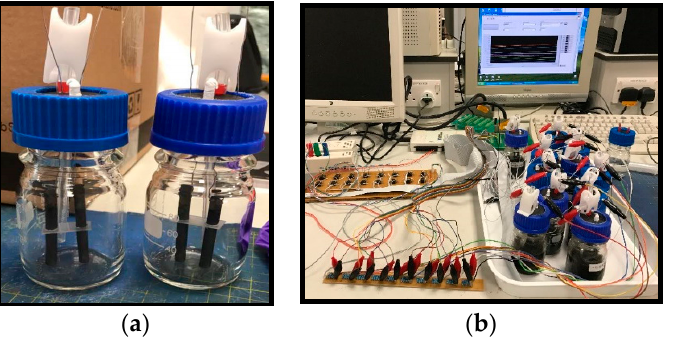
Figure 1. Picture ( a ) of single-chamber bioelectrochemical reactors used in the study. Experimental setup ( b ) adopted to apply the difference of potential between electrodes in each reactor.